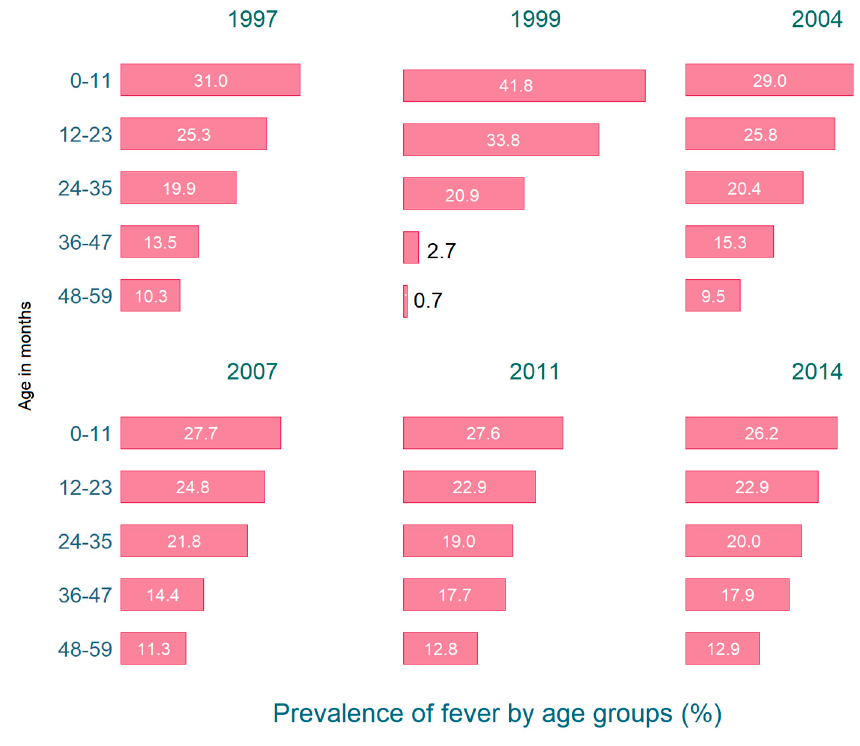
Figure 1. Prevalence of fever among under-five children in Bangladesh 1997–2014.